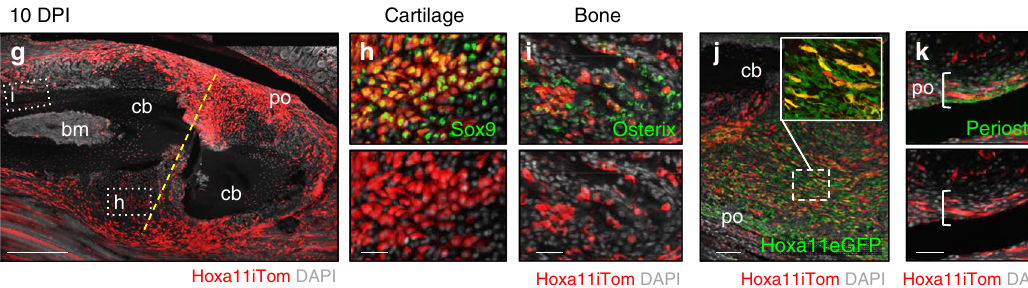
Fig. 6 Hoxa11 -lineage cells regenerate skeleton following fracture. Ulnar fracture was performed at 8 weeks of age ( a – f ) or 10 months ( g – k ) on Hoxa11- CreER T2 ;ROSA-tdTomato or Hoxa11eGFP;Hoxa11-CreER T2 ;ROSA-tdTomato mice following tamoxifen dosing at ( a – c ) E13.5 — to pregnant female, or ( d – k ) P3. a , d , g Hoxa11 lineage-positive cells (Hoxa11iTom, red) within the fracture callus 10 days post-injury (DPI). Fracture line marked with dashed yellow line and cortical bone (cb), bone marrow (bm), and periosteum (po) are labeled. Dashed white lines indicate regions visualized with antibodies (green) for cartilage (Sox9, b , e , h ) and bone (Osx, c , f , i ). Higher magni fi cation of regions marked by dashed white lines ( b , c , e , f ) with channels separated shown to right. ( j ) Expression of Hoxa11eGFP (green) and Hoxa11iTom within the expanded stromal population. White dashed box magni fi ed in inset. k Expression of Periostin (green) and Hoxa11iTom within the expanded periosteal compartment (bracket). In all images, gray: DAPI. Scale bars: ( a , d , g ) 500 μ m, ( b , c , e , f ) 200 μ